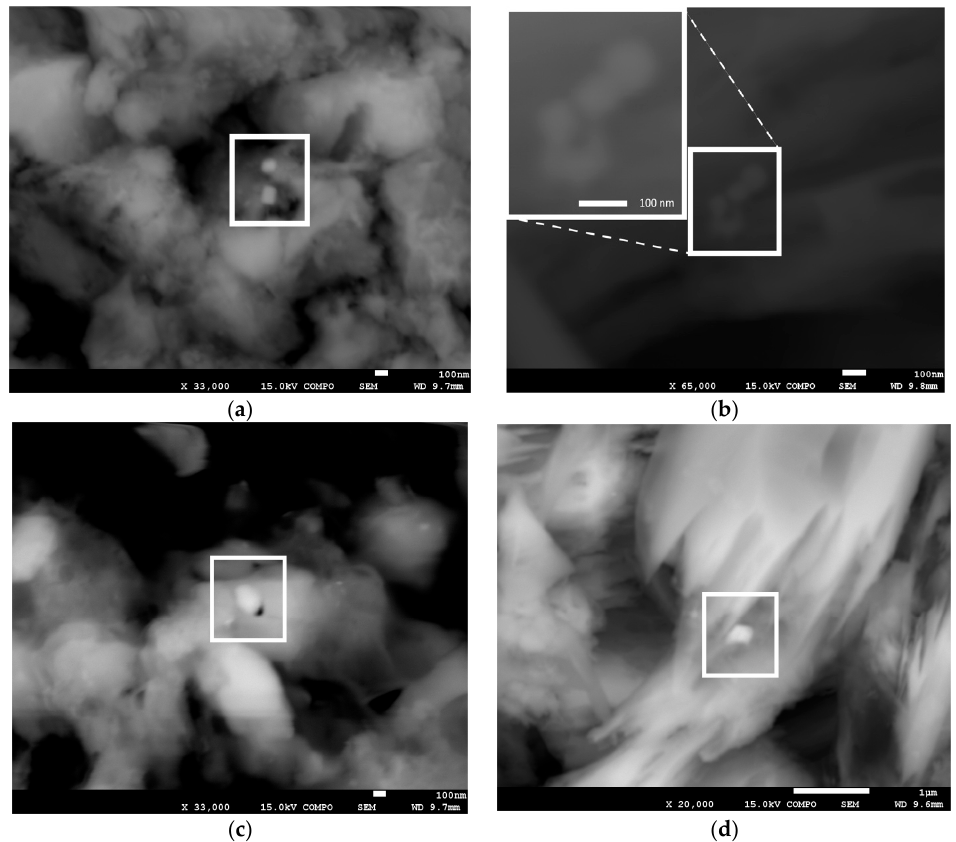
Figure 4. ( a ) SEM image of iron oxides in Boulder KK showing a similar shape and size as those of biogenic magnetite. ( b ) SEM image of iron oxide in K09 from Porites colony aligned in a chain-like structure. The inlet shows a larger and brighter image of the iron oxide grains. ( c , d ) SEM images of iron oxides that represent a different shape from biogenic magnetite in Boulder KK and K09, respectively.